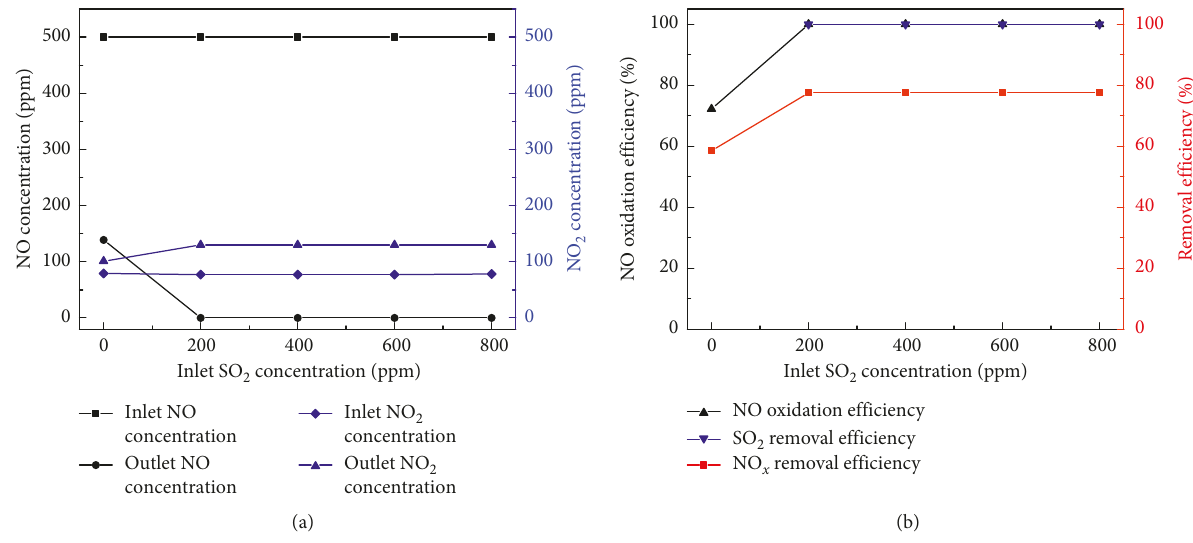
Figure 6: Changes of NO